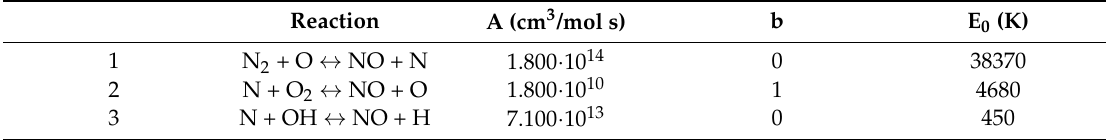
Table A1. Zeldovich